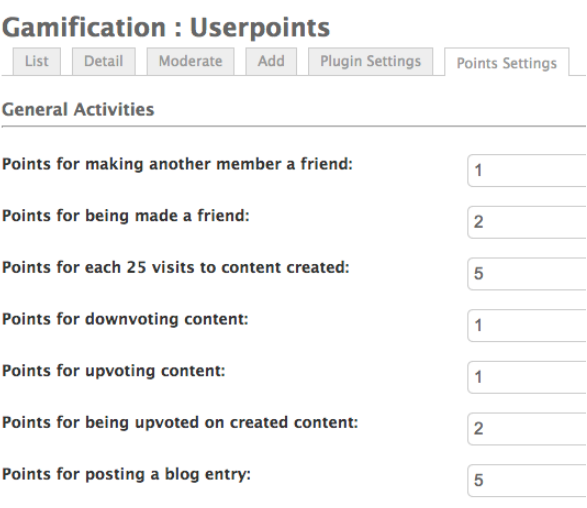
Fig. 4 SEGAN Gamification administration panel